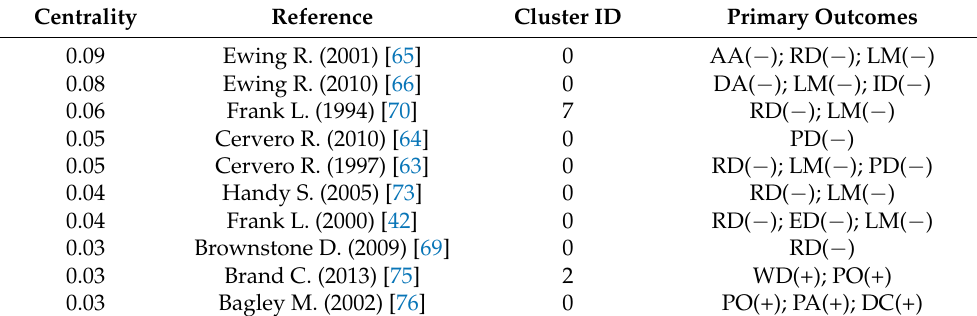
Table 4. Top-10 co-citation centrality of the